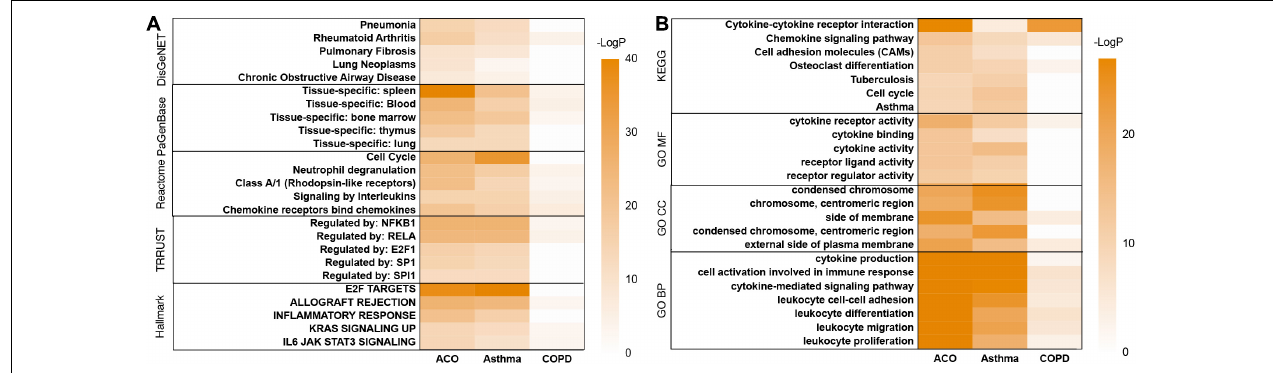
FIGURE 3 | Metascape’s analysis of gene expression trends of three models. (A) disease pattern analyzed by using DisGeNET, PaGenBase, Reactome, TRRUST, Hallmark. (B) enrichment analysis and functional annotation of the selected genes performed by GO and KEGG database.